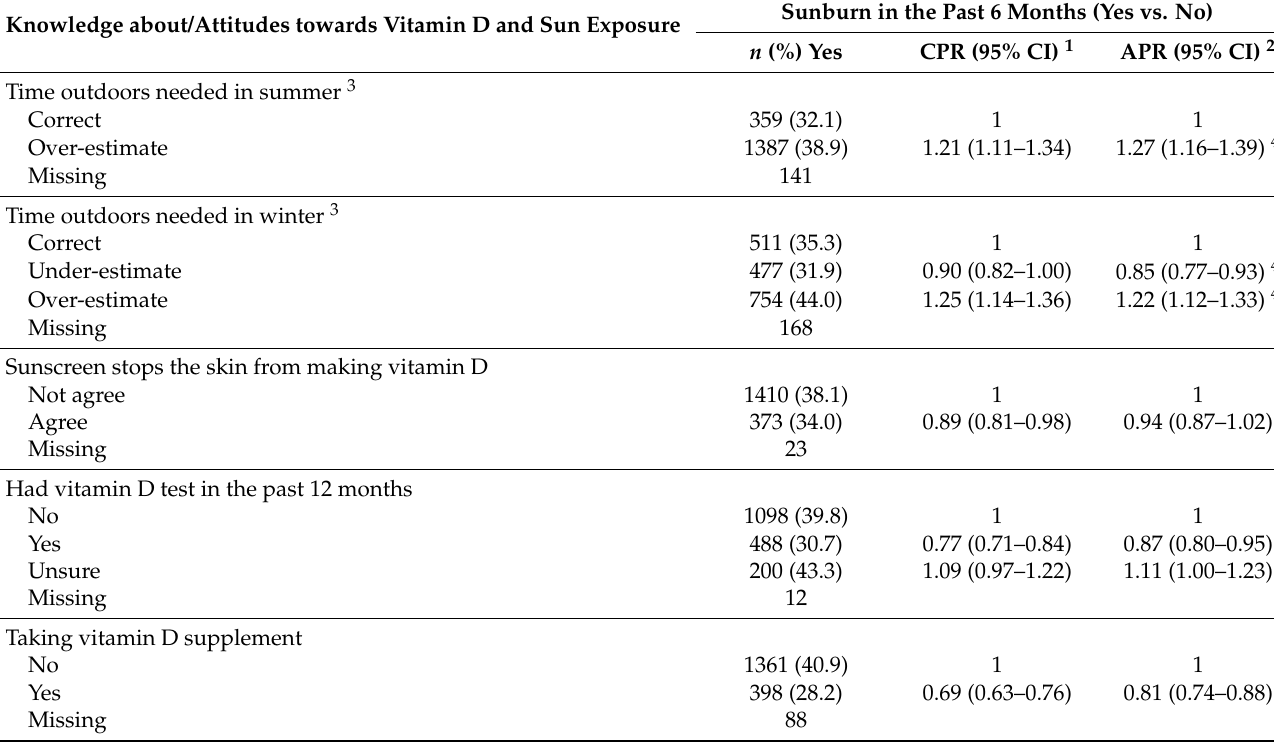
Table 6. Associations between knowledge about/attitudes towards vitamin D/sun exposure and being sunburnt in the past 6